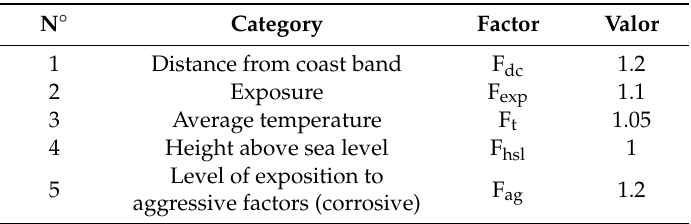
Table 6. Summary of Location Factor